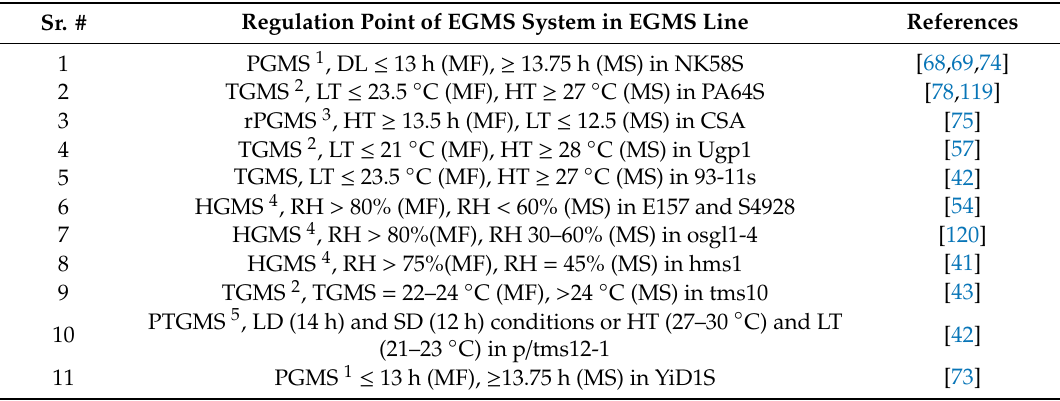
Abbreviations: 1 photoperiod-sensitive-genic-male-sterility, 2 temperature-sensitive-genic-male-sterility, 3 reverse- photoperiod-sensitive-genic-male-sterility, 4 humidity-sensitive-genic-male-sterility, 5